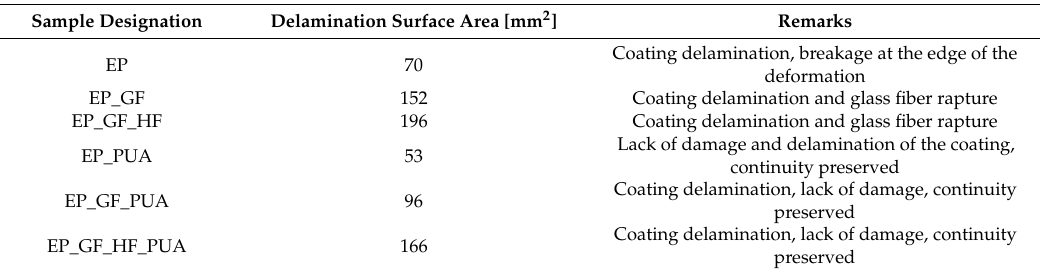
Table 9. Coating damage after the impact resistance test.